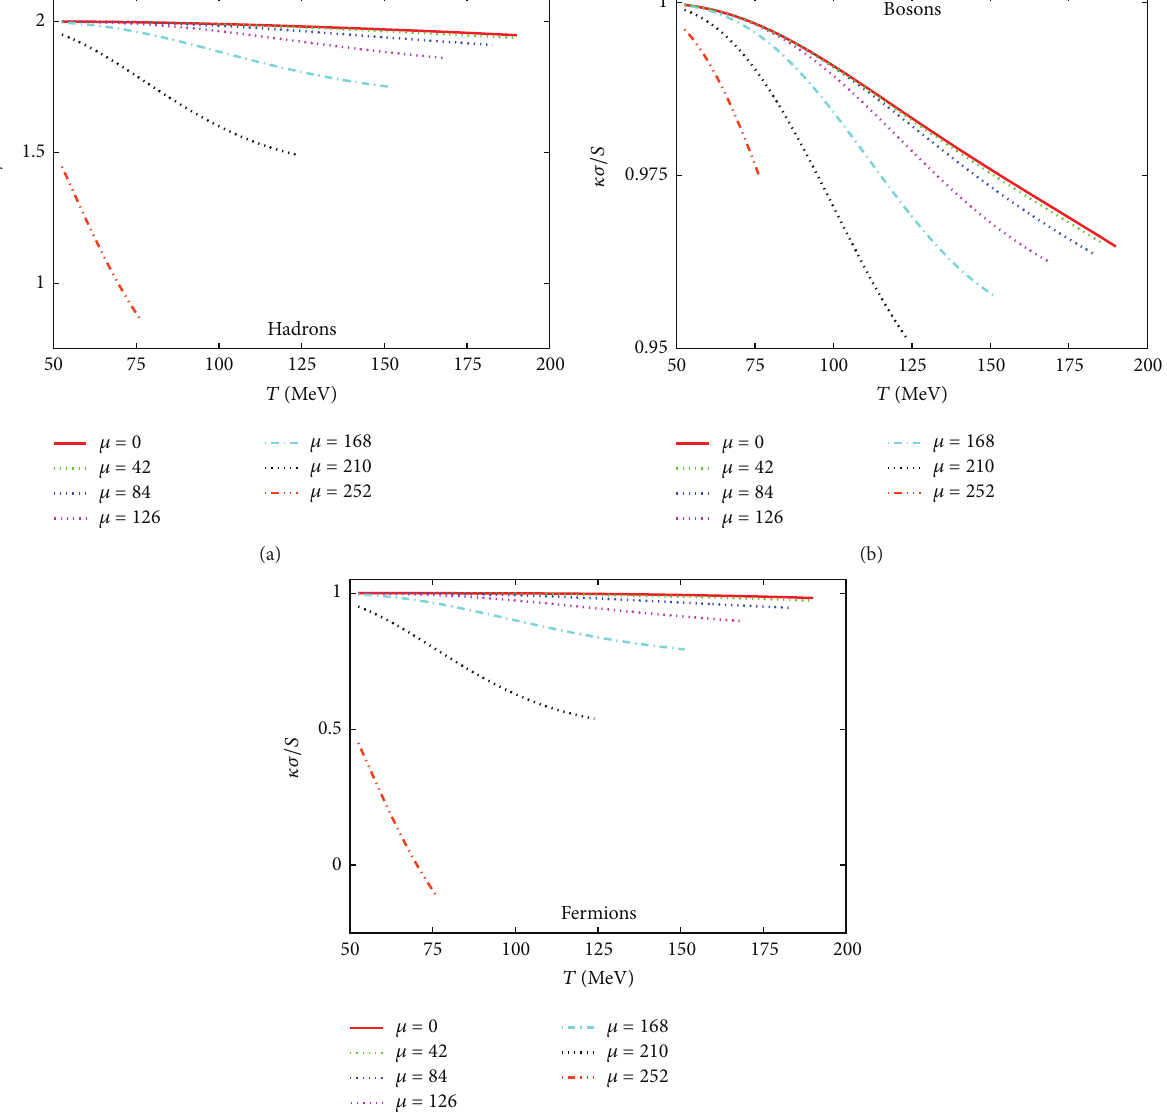
maximum over ∼ 0.25 GeV. Then both curves come closer to each other. They cross again over ∼ 0.2 GeV.